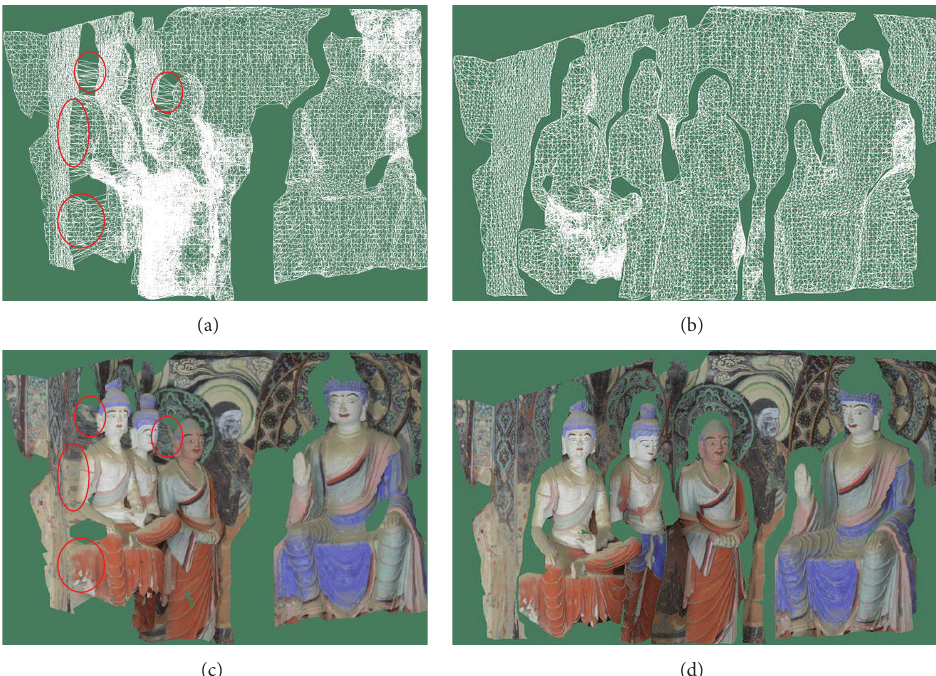
Figure 5: The point cloud classification optimization: (a) original triangular mesh, (b) triangular mesh after clustering, (c) original 3D model, and (d) 3D model after